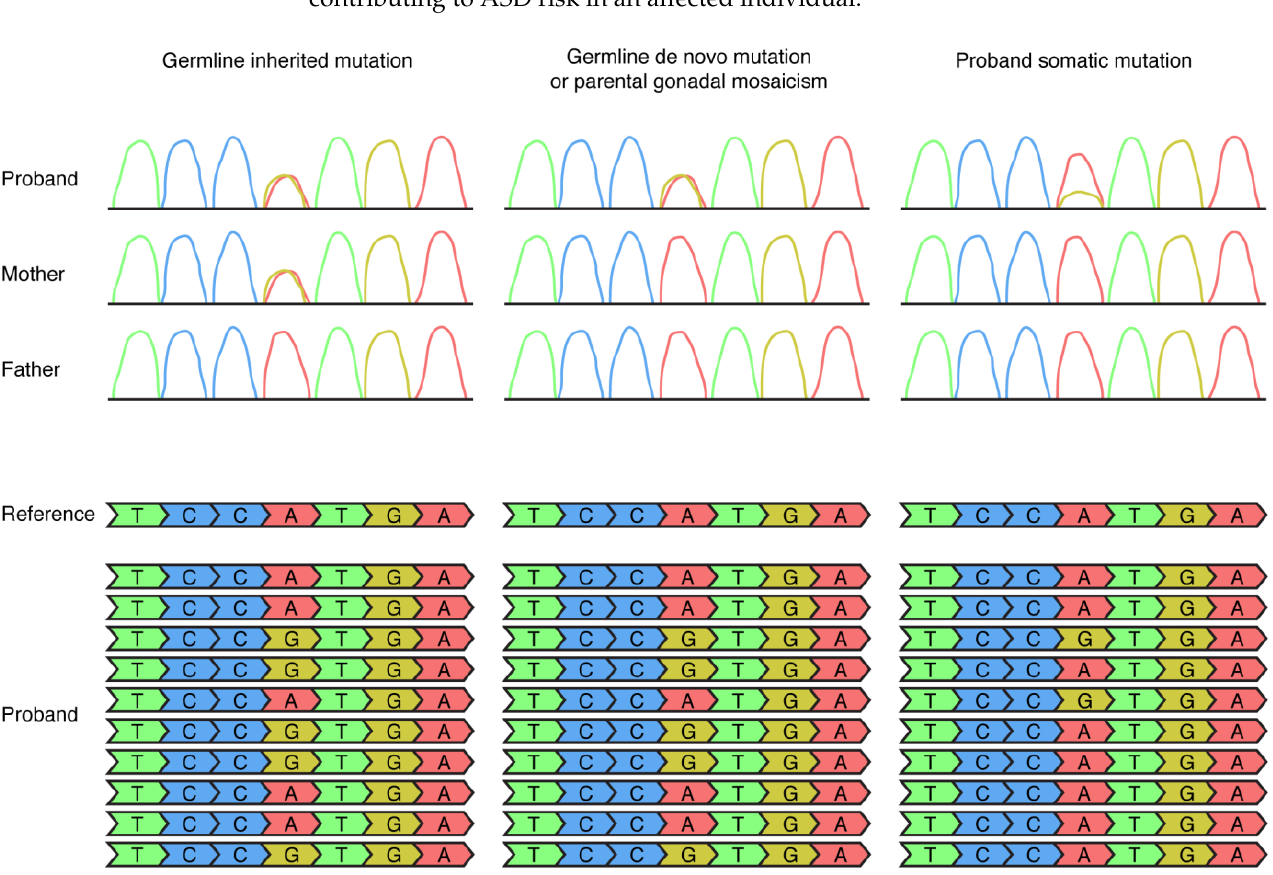
Figure 1. Detection of germline and somatic mosaic mutations by Sanger sequencing (top row) and next-generation sequencing (bottom row) approaches in DNA extracted from clinically accessible tissues such as blood. In this figure the example of an A (depicted in red) to G (depicted in yellow) mutation is used. A germline inherited mutation, in this example a heterozygous mutation inherited from the mother, is detectable as a heterozygous mutation in Sanger sequencing of both the proband and the mother and detectable in 50% of the NGS reads of the proband. A germline de novo mutation or a parental gonadal mosaic mutation is detectable as a heterozygous mutation in Sanger sequencing of the proband, not detectable in Sanger sequencing of the parents, and detectable in 50% of the NGS reads in the proband. A somatic mutation is sometimes detectable in Sanger sequencing of the proband (in this example, as the small yellow peak) and is detectable in <50% of the NGS reads (in this example, 20% of the NGS reads) in the proband.